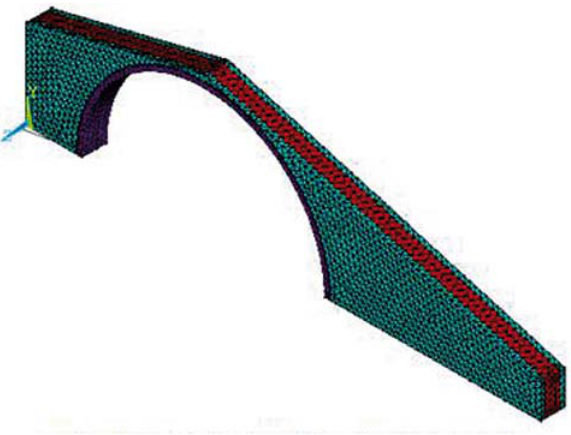
Fig. 4. FEM of Şenyuva historical arch